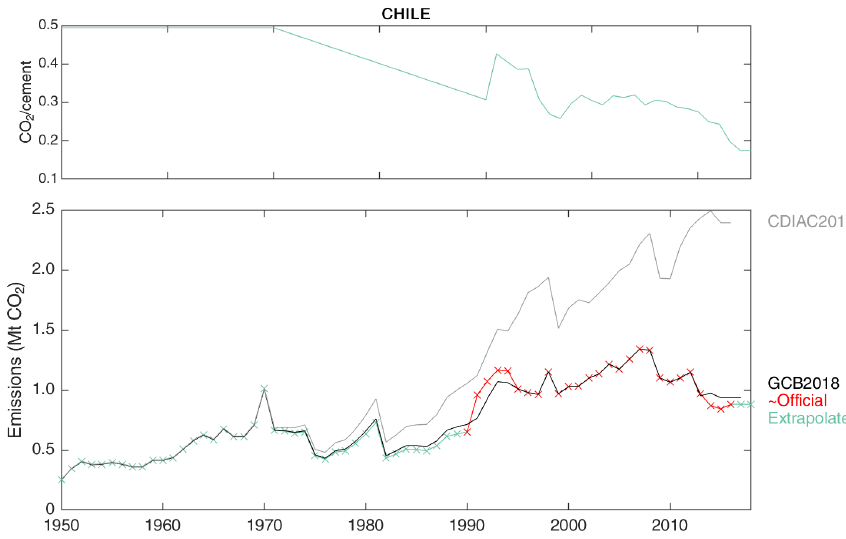
Figure C17. Revised cement emissions for Chile.